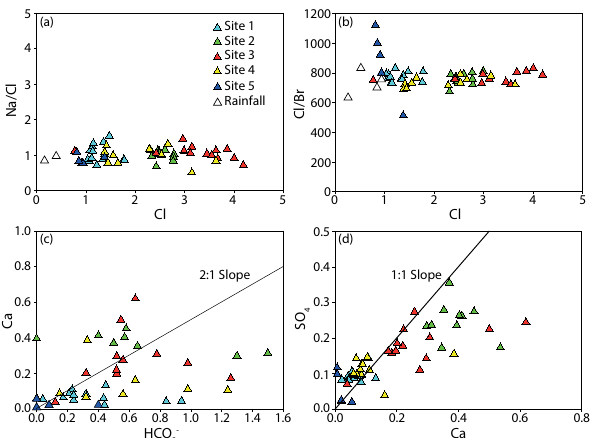
Figure 3. Geochemical characteristics of groundwater in the East- ern View Formation: (a) mCl/Br vs. mCl; (b) mNa/Cl vs. mCl; (c) mCa vs. mHCO 3 ; (d) mSO 4 vs. mCa. Rainfall samples are also plotted where measured. Data are from Table 1 with repeat mea- surements over the sampling period